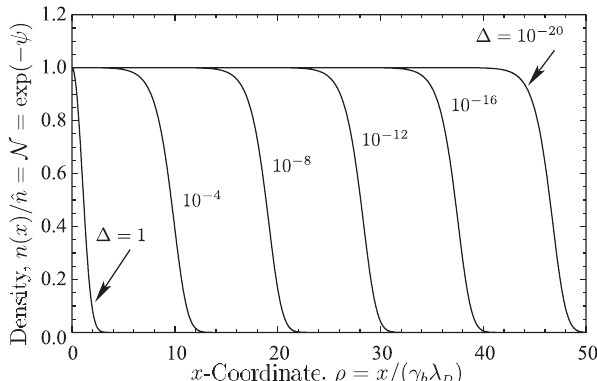
FIG. 2. Scaled density N ¼ n ð (cid:11) Þ = ^ n ¼ exp ð(cid:1) c Þ plotted ver- sus the scaled x coordinate (cid:11) ¼ x= ð (cid:2) solution of the transformed thermal equilibrium Poisson equa- tion (55) for indicated values of (cid:3)